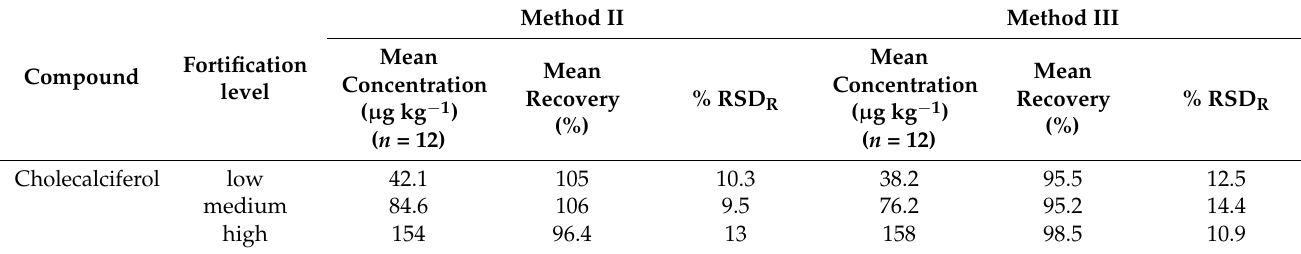
Table 6. Comparative results of recoveries and precision for Vitamin D3.